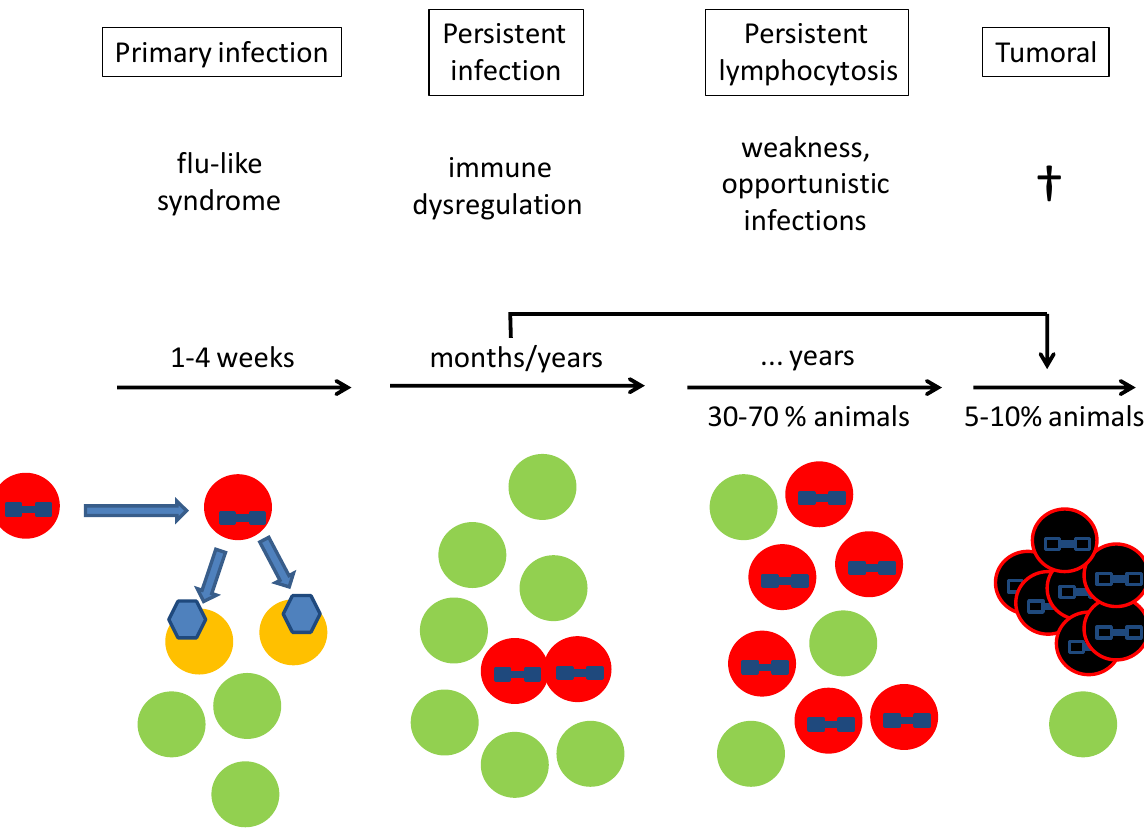
Figure 1. Clinical course of bovine leukemia virus (BLV) infection. Primary infection: an infected cell (red) with a BLV integrated into the host chromosome (blue provirus) is transmitted into a new animal. During primary infection, the BLV provirus is expressed into viral particles (blue hexagon), which further infect B-cells (yellow). Active BLV replication is responsible for a “flu-like” syndrome, as observed during primary infection by HIV in humans. During persistent infection, provirus-carrying cells (red) expand mainly by mitosis, because of the presence of an active immune response. This phase extends for several months/years and is characterized by an immune dysregulation (e.g., overexpression of cytokines), as observed in HTLV associated myelopathy / tropical spastic paraparesis (HAM/TSP) subjects infected by human T-lymphotropic virus type 1 (HTLV-1). In about 30%–70% of animals, the number of infected cells in blood increases above normal levels of 10,000/mm 3 . During this persistent lymphocytosis phase, morbidity is characterized by weakness and opportunistic infections, as observed in chronic lymphocytic leukemia in human. Morbidity (e.g., mastitis) leads to a loss in milk production. In the tumor phase, a single infected cell undergoes genetic mutations (black) and forms a lymphoma within or outside lymph nodes, leading to the death of the animal. Typically, animals undergo sudden death from the hemorrhage of the spleen. Tumors can also occur directly in persistently infected animals without persistent lymphocytosis (PL). The frequency of tumors and clinical latency depend on herd prevalence. A typical picture is 10% death after three years in a herd having 50% BLV